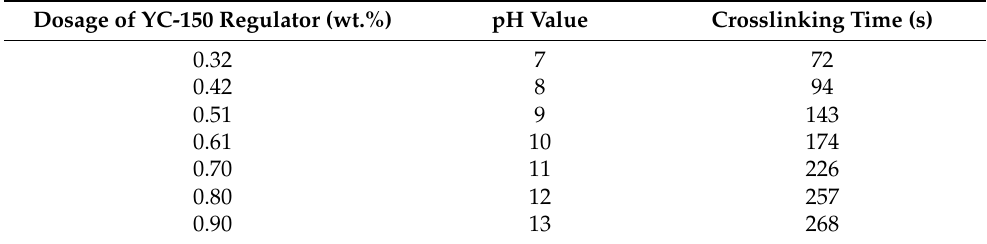
Table 6. Crosslinking time of the fracturing fluid under different pH conditions. Dosage of YC-150 Regulator